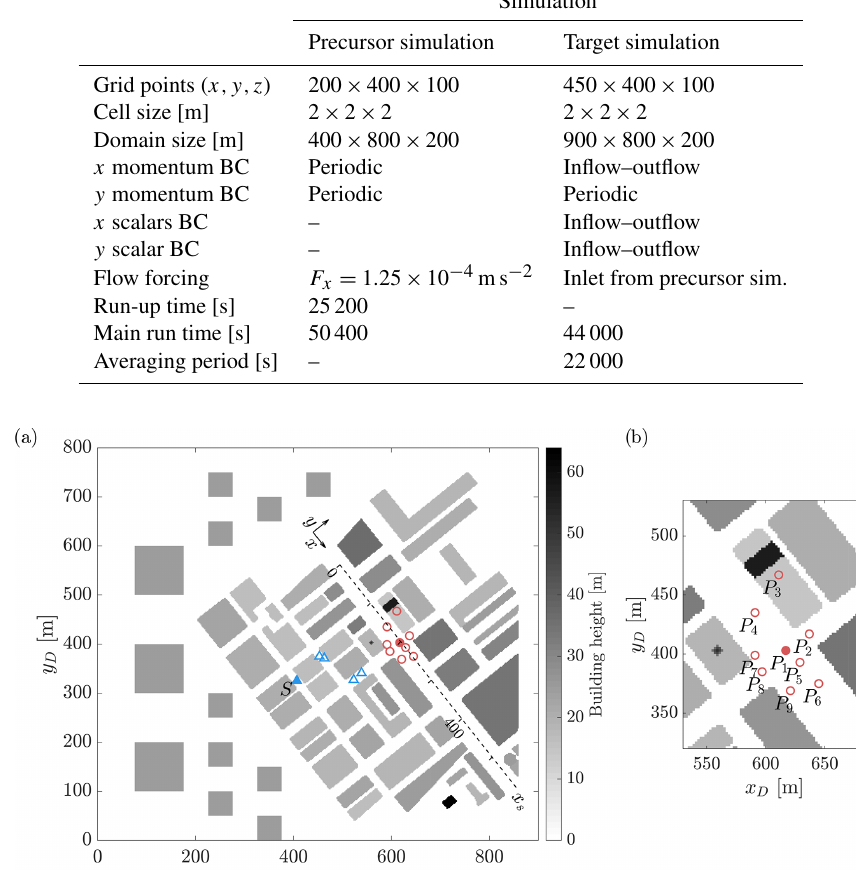
Figure 7. Diagrammatic view of the (a) urban morphology in the DAPPLE simulation and (b) detailed view of the main intersection of Marylebone Road and Gloucester Place with positions of velocity profile measurements P 1 – P 9 (circles) around the intersection and positions of the upstream scalar releases (triangles). Velocity measurements at point P 1 (filled circle) and the spanwise pollutant concentration along Marylebone Road (along the horizontal axis x s ) from scalar release at point S (filled triangle) are shown in Figs. 9 and 10. Additional axes x and y are aligned with Marylebone